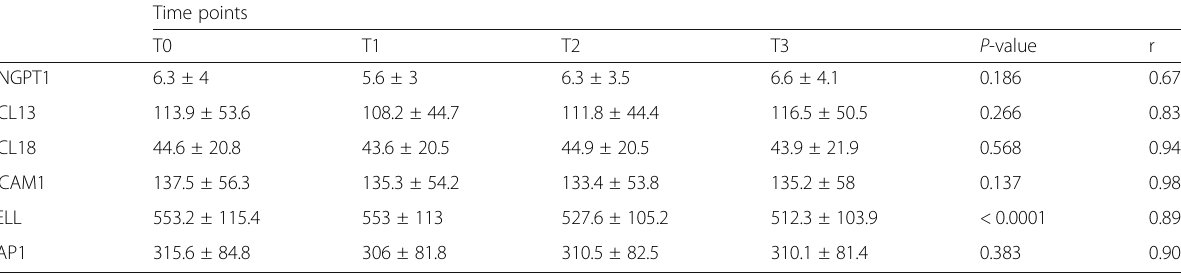
Protein levels were evaluated in 56/60 patients. Protein abbreviations are reported as in Table 2 The P value of ANOVA for repeated measures across time is reported r=Pearson coefficient of correlations across 4 time